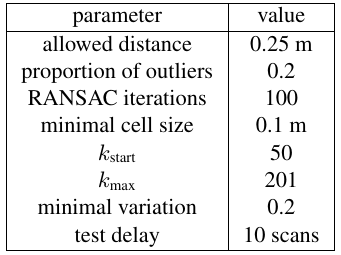
Table 1. Default values for the parameters.